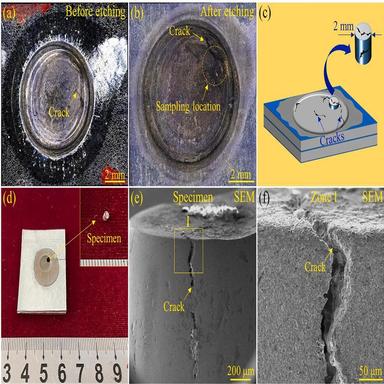
Appearance of the resistance spot welded joint and the morphology details of the columnar specimen distracted from the crack region for the subsequent XRM analysis: (a) surface morphology of the spot weld before etching, (b) surface morphology of the spot weld after etching, (c) the schematic of the sampling location, (d) appearance of the whole welded joint after etching, the inset is the sampled specimen for the XRM characterization, (e) SEM image of the columnar specimen, and (f) exterior morphology deta